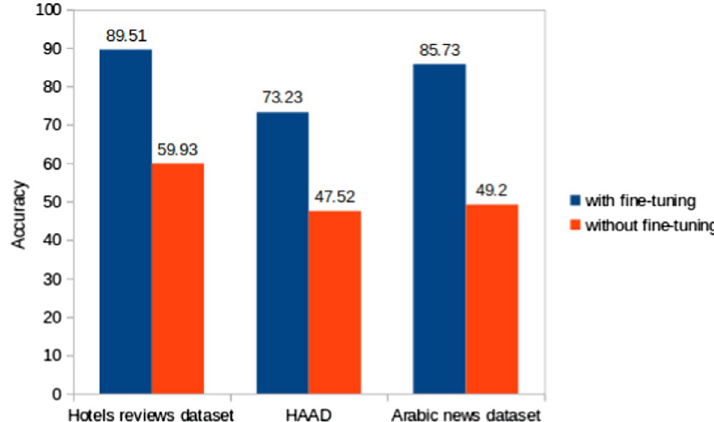
Fig. 6 Effect of fine-tuning BERT on different datasets